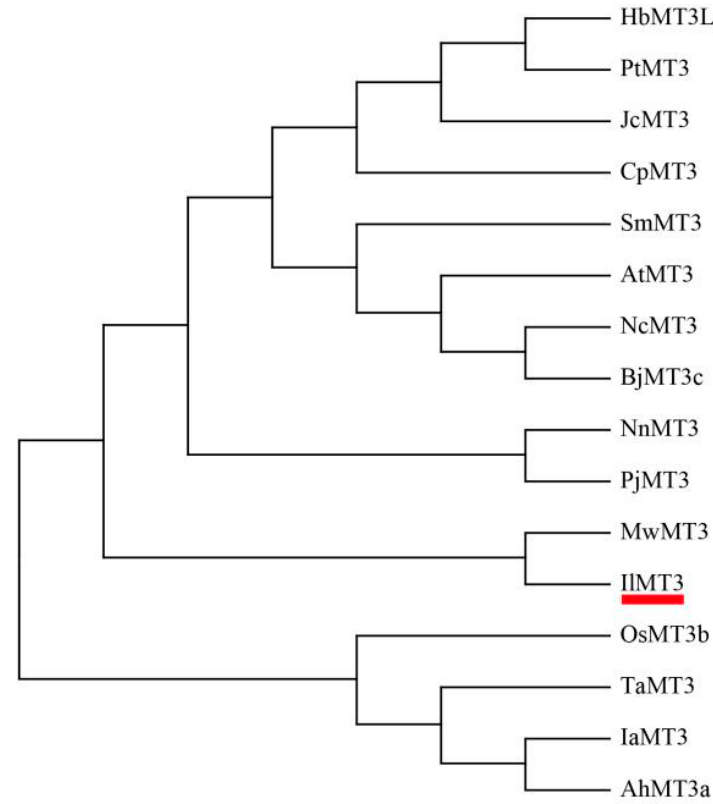
Figure 3. Phylogenetic analysis of IlMT3.